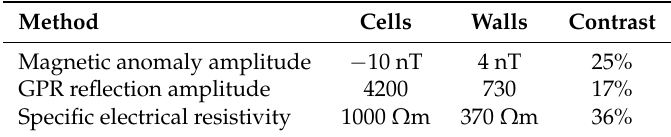
Figure 6. ( a ) Cracked conglomerate rocks in the vicinity of the investigation site. ( b ) Drawing of two exemplary chamber tombs on the Peloponnese (after [52]). Table 4. Summary of physical properties derived from the geophysical measurements (cf. Figure 5). The values are averaged and rounded for three cell-wall-pairs over an circular area of 0.8 m 2 over a depth range of 0.5–1 m (for ground-penetrating radar and electrical resistivity tomography). The contrast column shows the percentage of the amplitudes of the wall in reference to the amplitude of the cells. For the magnetic anomaly the absolute difference is taken as